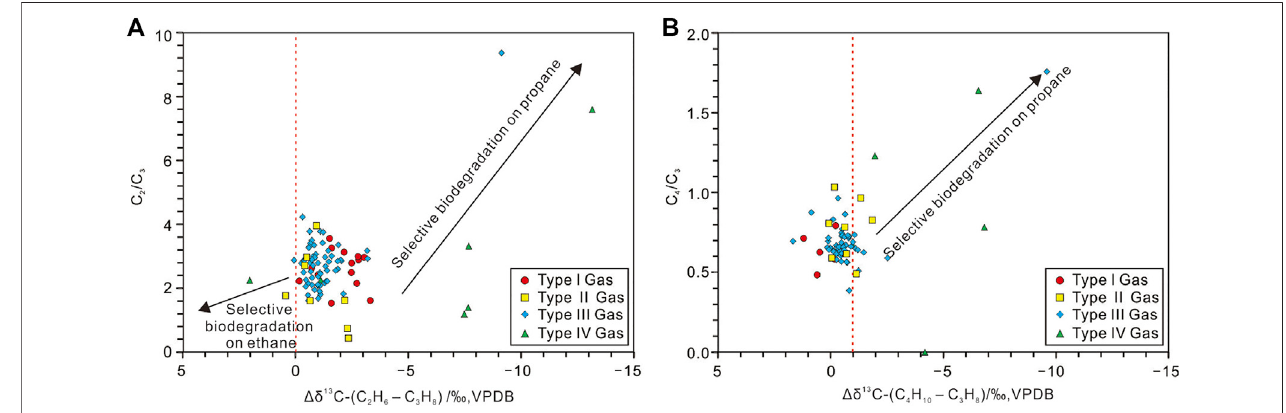
FIGURE 12 | Cross plots of (A) Δδ 13 C-(C 2 H 6 – C 3 H 8 ) vs. C 2 /C 3 and (B) Δδ 13 C-(C 4 H 10 – C 3 H 8 ) vs. C 4 /C 3 of natural gas in the hinterland of Junggar